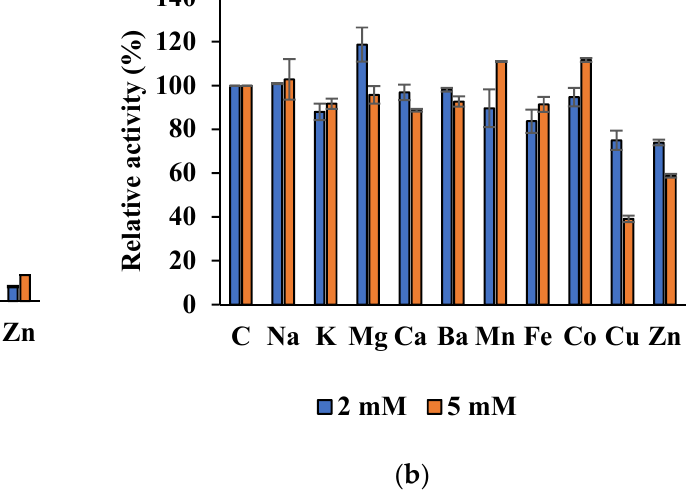
Figure 10. Effects of cations on activities of Es8L ( a ) and Est13L ( b ). In the hydrolysis of glyceryl esters, Est8L and Est13L preferred glyceryl tributyrate (C4). After hydrolysis for 60 min under the condition described in Materials and Methods, Est8L and Est13L showed similar patterns for hydrolysis of glyceryl triesters and oils; for glyceryl tributyrate, they showed hydrolysis of 16.1% and 15.6%, respectively, and for fish oil, they showed hydrolysis of 86.7% and 82.6%, respectively. Both enzymes showed no significant activities with glyceryl trioleate (C18) and olive oil (Figure 11).